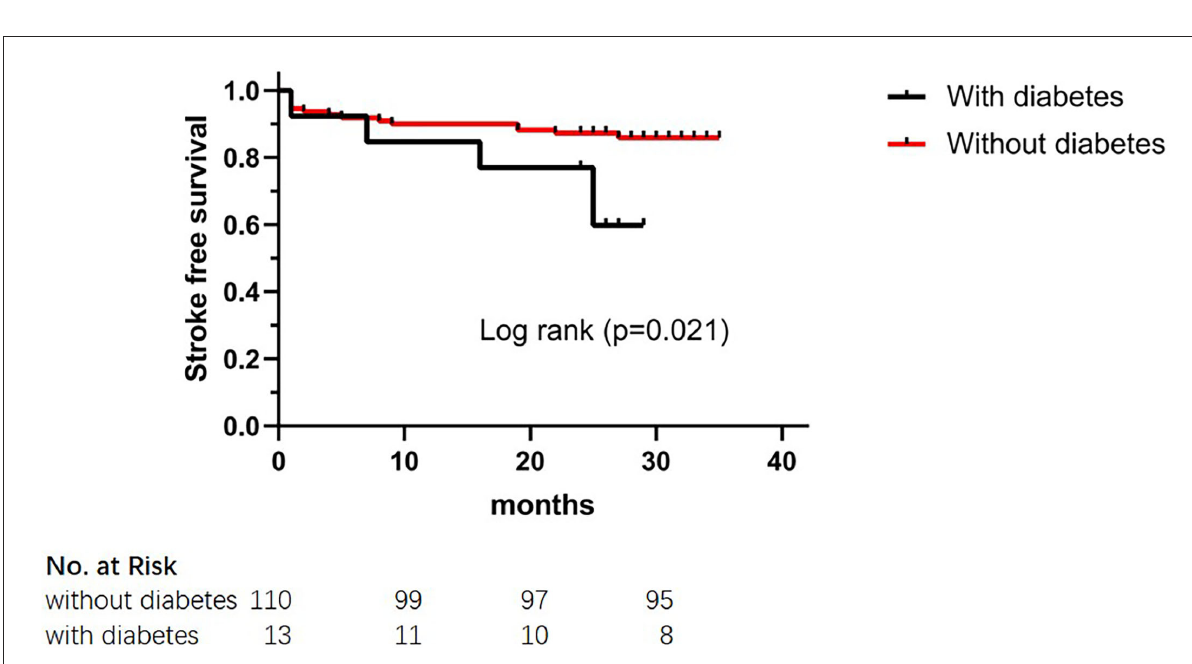
FIGURE2 The Kaplan–Meier cumulative hazard curve for stroke recurrence comparing participants with diabetes and participants without diabetes.